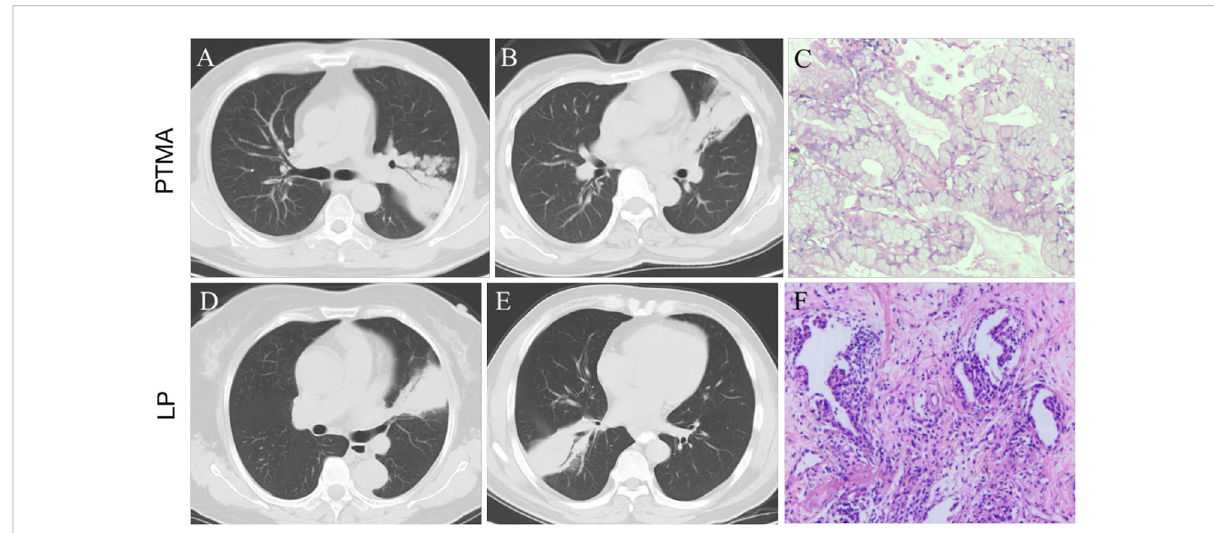
FIGURE 9 (A, B) : pneumonic-type mucinous adenocarcinoma (PTMA) patients with CT scan. (C) : Photomicrograph (hematoxylin and eosin staining,×200) con fi rming invasive mucinous adenocarcinoma with an acinar-predominant pattern. (D, E) : lobar pneumonia (LP) patients with CT scan. (F) : Photomicrograph con fi rming chronic in fl ammatory cell in fi ltration with fi brous tissue